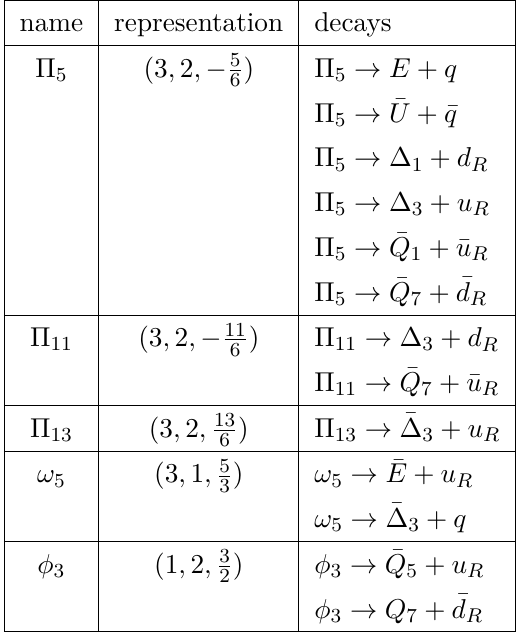
Table 9. Decay channels for non-exit scalar loop